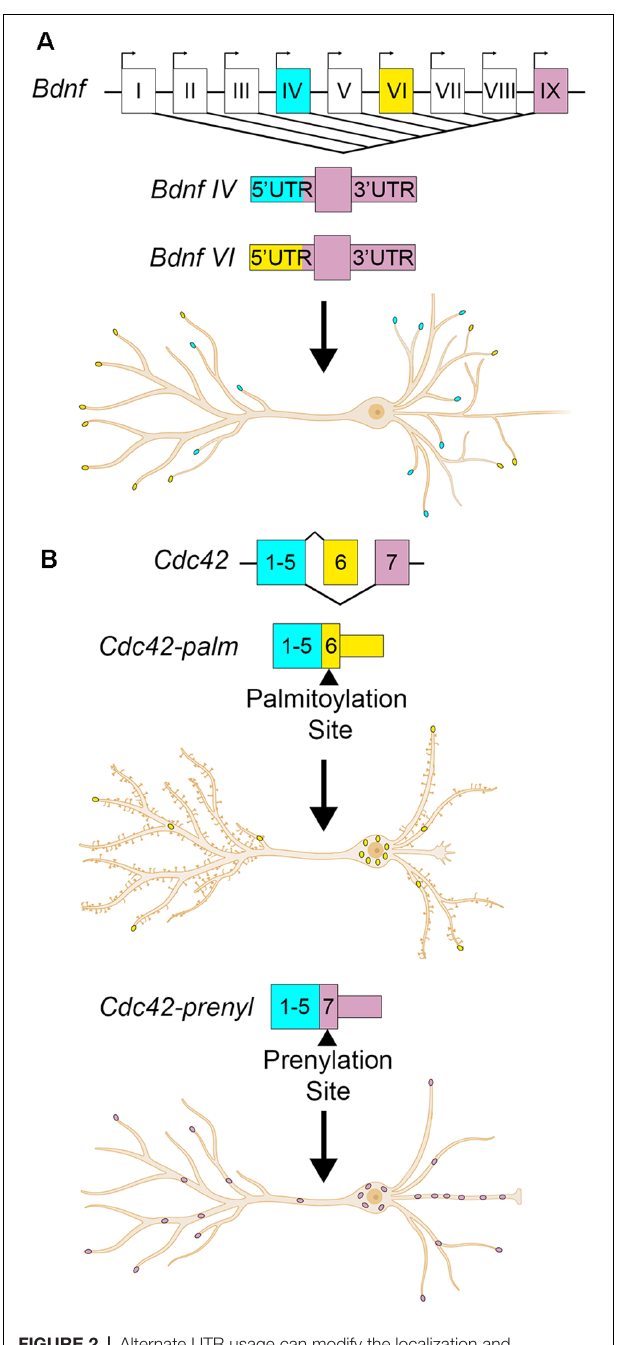
FIGURE 2 | Alternate UTR usage can modify the localization and developmental effects of a transcript. (A) Bdnf transcription can begin from one of nine alternate promoters. The promoter choice affects the 5 (cid:48) UTR sequence, but not the coding sequence or 3 (cid:48) UTR. Bdnf transcribed from the fourth promoter (cyan dots) localizes to proximal dendrites, while transcription from the sixth promoter localizes it to distal dendrites (yellow dots). Bdnf IV localization to proximal dendrites promotes dendritic formation. (B) Cdc42 has alternate last exons that determine its 3 (cid:48) UTR. The upstream last exon localizes Cdc42 mostly to the cell body of the neuron (yellow dots), and contains a palmitoylation site. This 3 (cid:48) UTR variant promotes spine formation. The downstream last exon containing a prenylation site enriches the transcript to neurites and axons (pink dots) and promotes axogenesis.